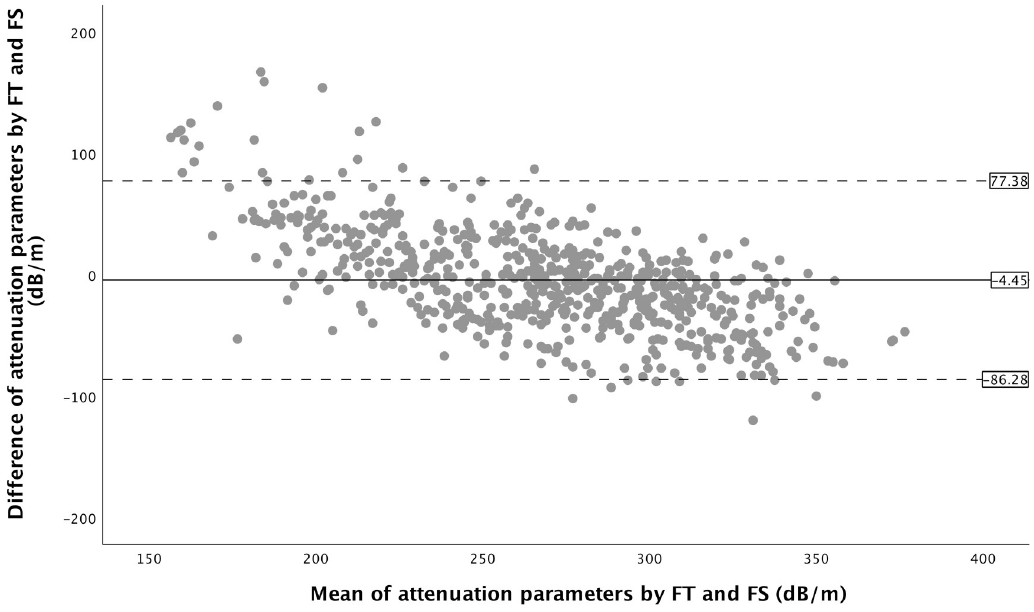
Fig 2. Bland-Altman plot of attenuation parameters obtained using FibroTouch (FT) and Fibroscan (FS).